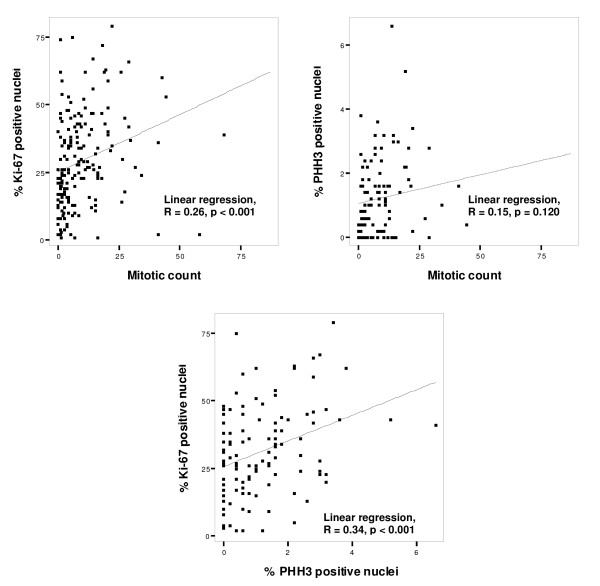
Scatter plots with regression lines illustrating the relationships between mitotic count (mitosis/mm2), Ki-67 expression and PHH3 expression.